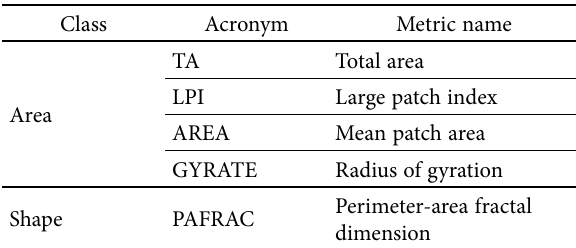
Table 1. Landscape metrics calculated in Fragststs (McGarigal et al.